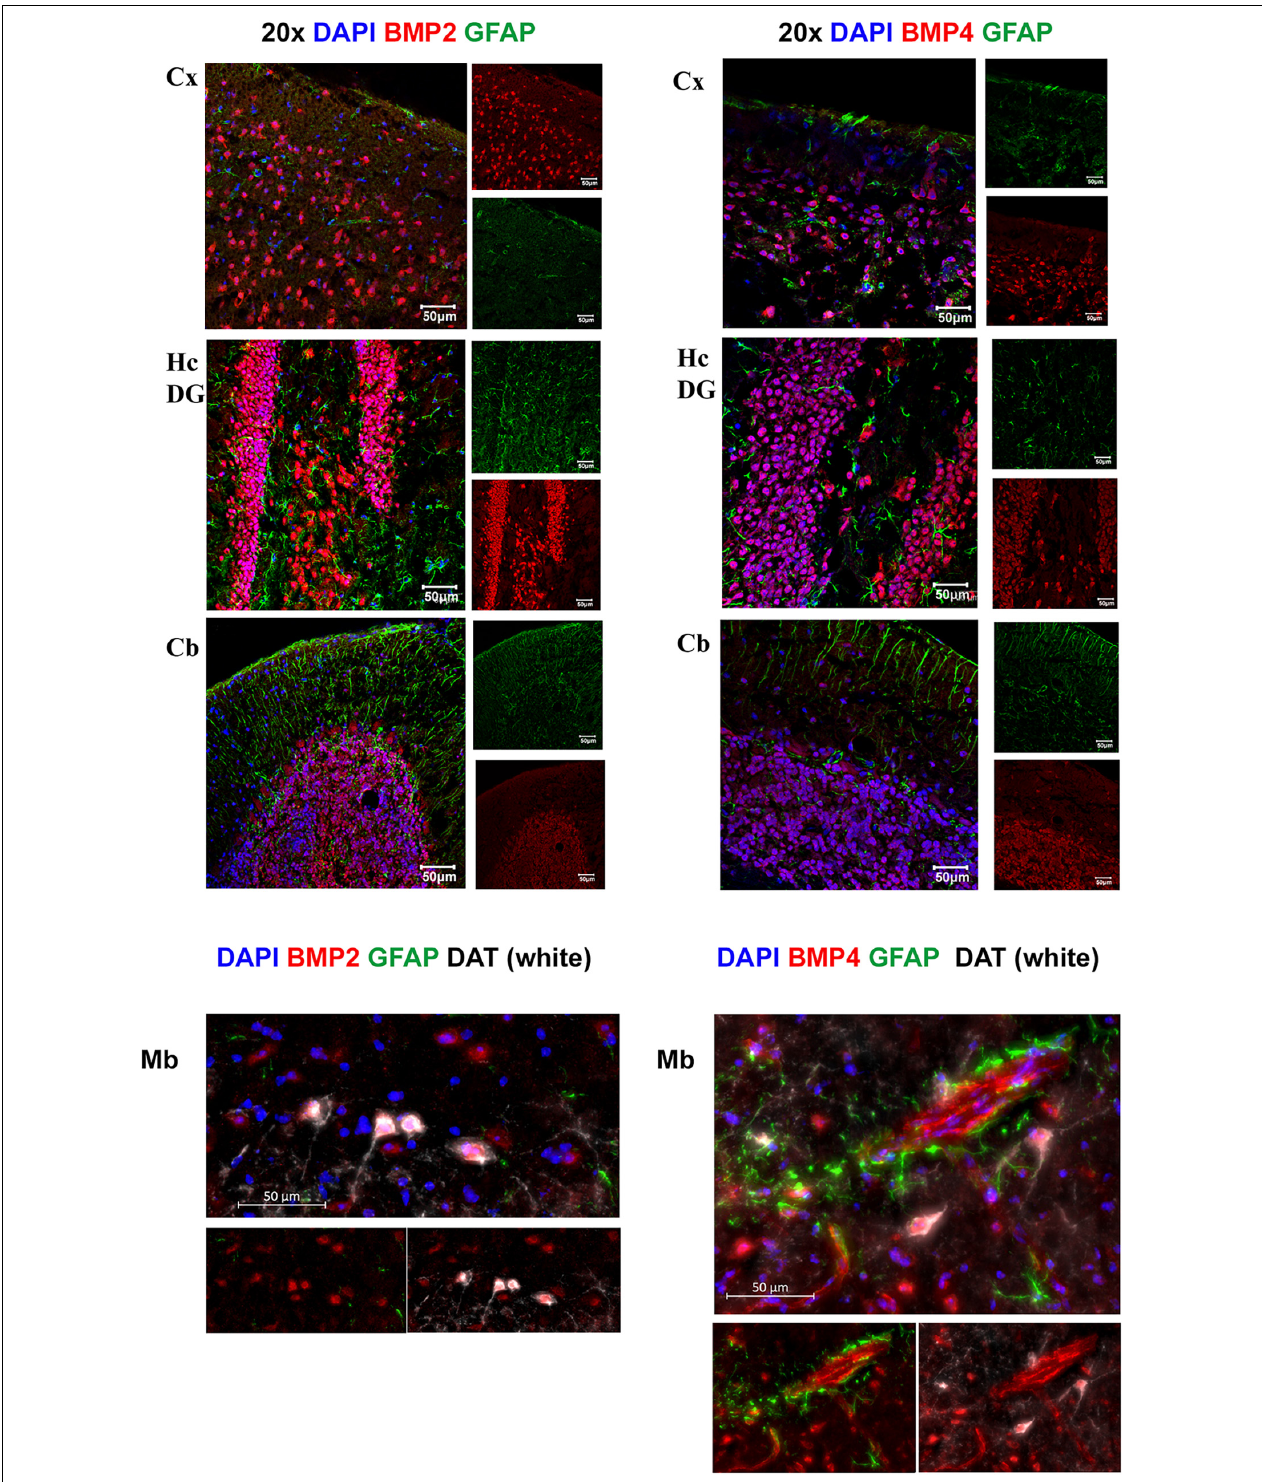
FIGURE 6 | BMP2 and BMP4 are mainly localized in neurons. Confocal images showing BMP2 and BMP4 (in red), the astrocyte marker Glial fibrillary acidic protein (GFAP; in green). Nuclear staining is shown in blue. BMP2 and BMP4 is expressed in neurons in cortex, hippocampus, cerebellum and midbrain. The staining does not co-localize with GFAP in the investigated regions. In midbrain, BMP2 and BMP4 expression is seen in dopaminergic neurons (DAT; white), while BMP4 staining is also observed in vessels. Cx, neocortex; Hc CA, hippocampus CA1 region; Hc DG, hippocampus dentate gyrus; Cb, cerebellum; Mb, midbrain. Scale bars = 50 µ